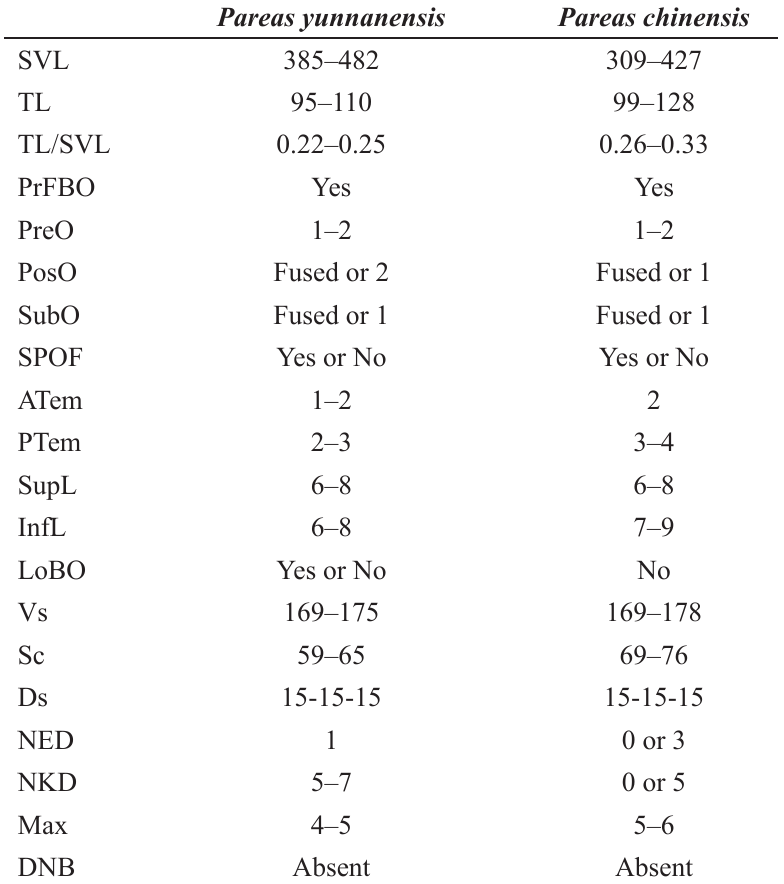
Table 4. Comparisons of morphometric and scalation data for Pareas yunnanensis (Vogt, 1922) and P. chinensis (Barbour, 1912). Measurements in mm, data for P. chinensis (restricted to Sichuan Province, China) from Poyarkov et al .